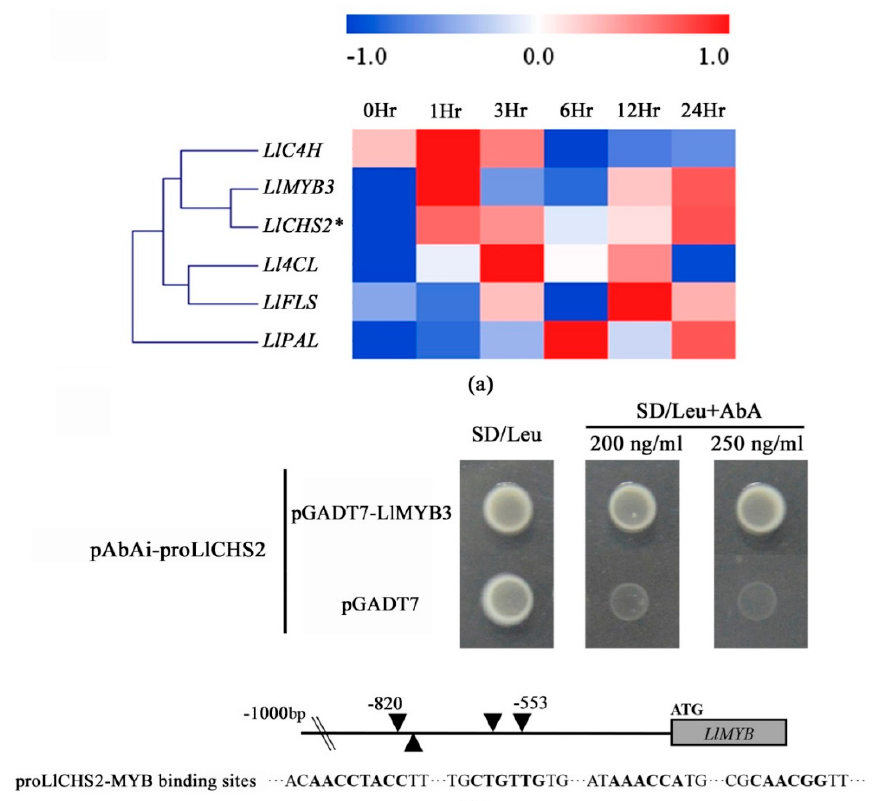
Figure 7. Yeast one-hybrid analysis of LlMYB3 binding to LlCHS2 promoter. ( a ) Correlation analysis of expression patterns of LlMYB3 and some structural genes involved in anthocyanin biosynthesis pathway under continuous cold treatment. ( b ) Yeast one-hybrid analysis and schematic representation of MYB binding sites in the LlCHS2 promoter. Yeast strain Y1HGold was co-transformed with bait (pAbAi-proLlCHS2) and a prey (pGADT7 or pGADT7-LlMYB3) construct. Interaction between bait and prey was determined by cell growth on SD medium lacking Leu in the presence of 200 and 250 ng·mL − 1 AbA.